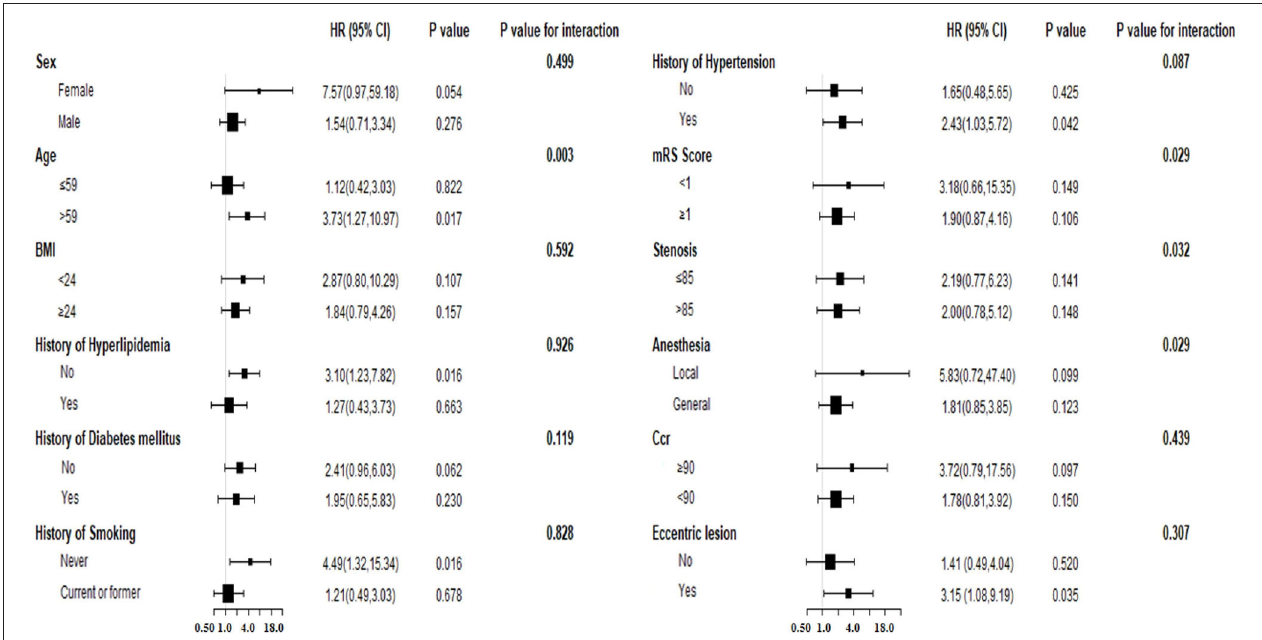
FIGURE 3 | The forest plot for subgroup analysis for association between PSM and long-term events. BMI, body mass index; Ccr, creatinine clearance; PSM, plaque surface morphology; HR, hazard ratio; CI, confidence